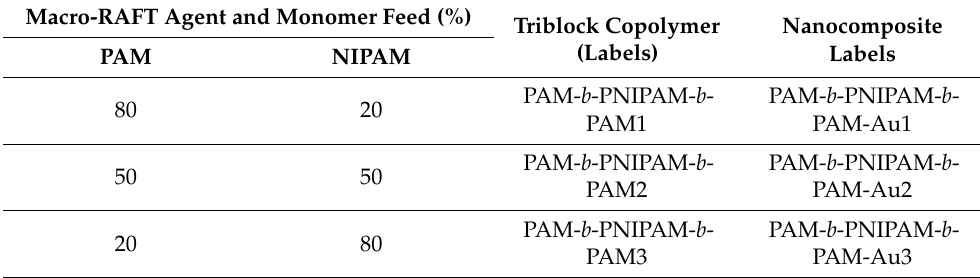
Nanocomposite (Labels)